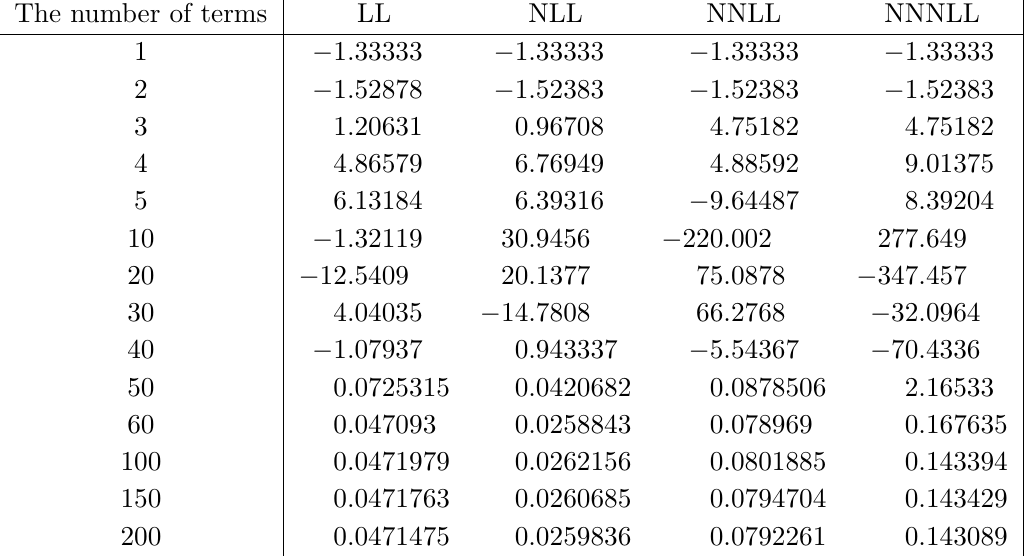
with using mapping (7.4) from truncated 3 = 2